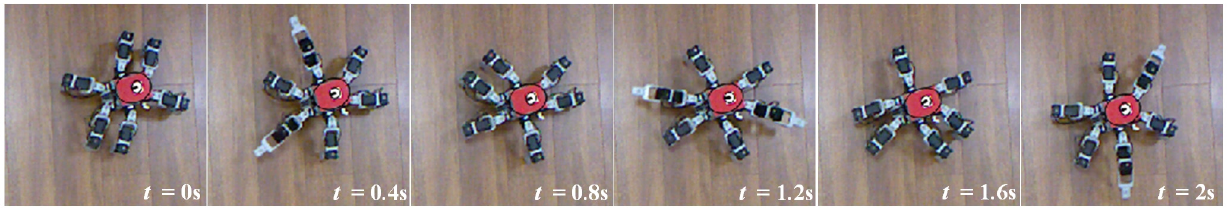
Figure 15. The experimental screenshots of the tetrapod gait.